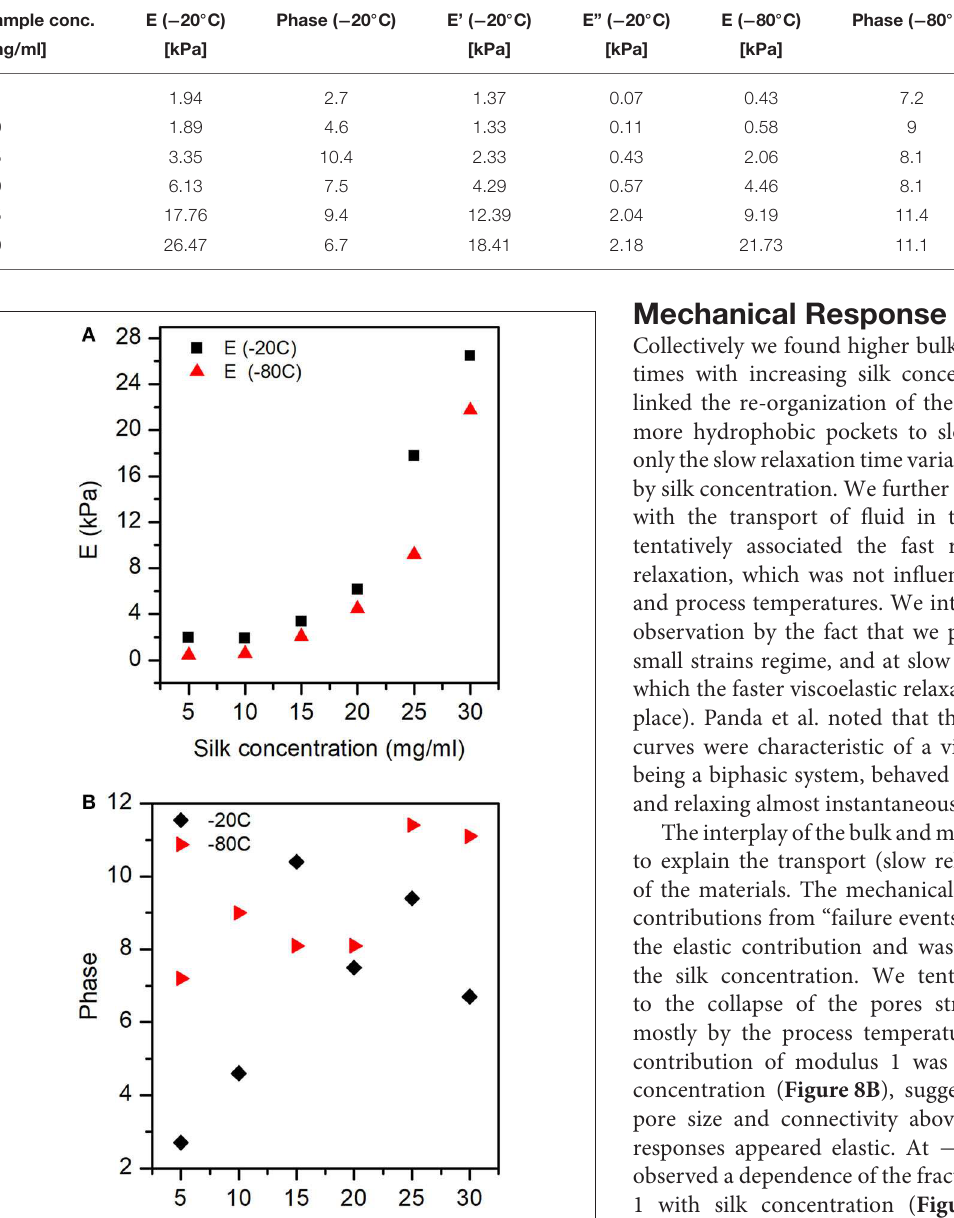
mimic tissue permeability. Still, the control of porosity